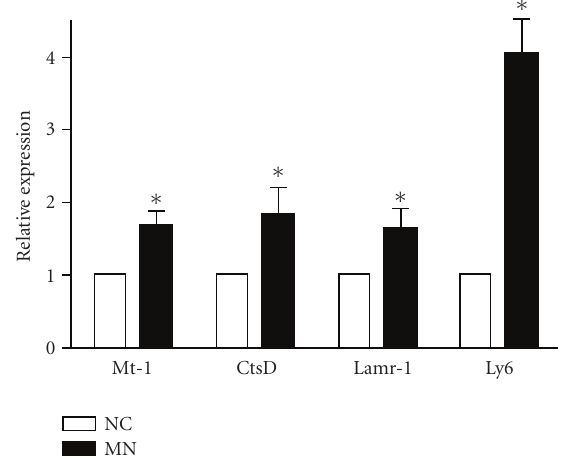
Figure 4: Candidate genes mRNA expression levels. Four candidate genes RNA were prepared from the kidney cortices of NC and MN mice, and the levels of mRNA expression were determined by RT- PCR ( n = 3). ∗ P < .